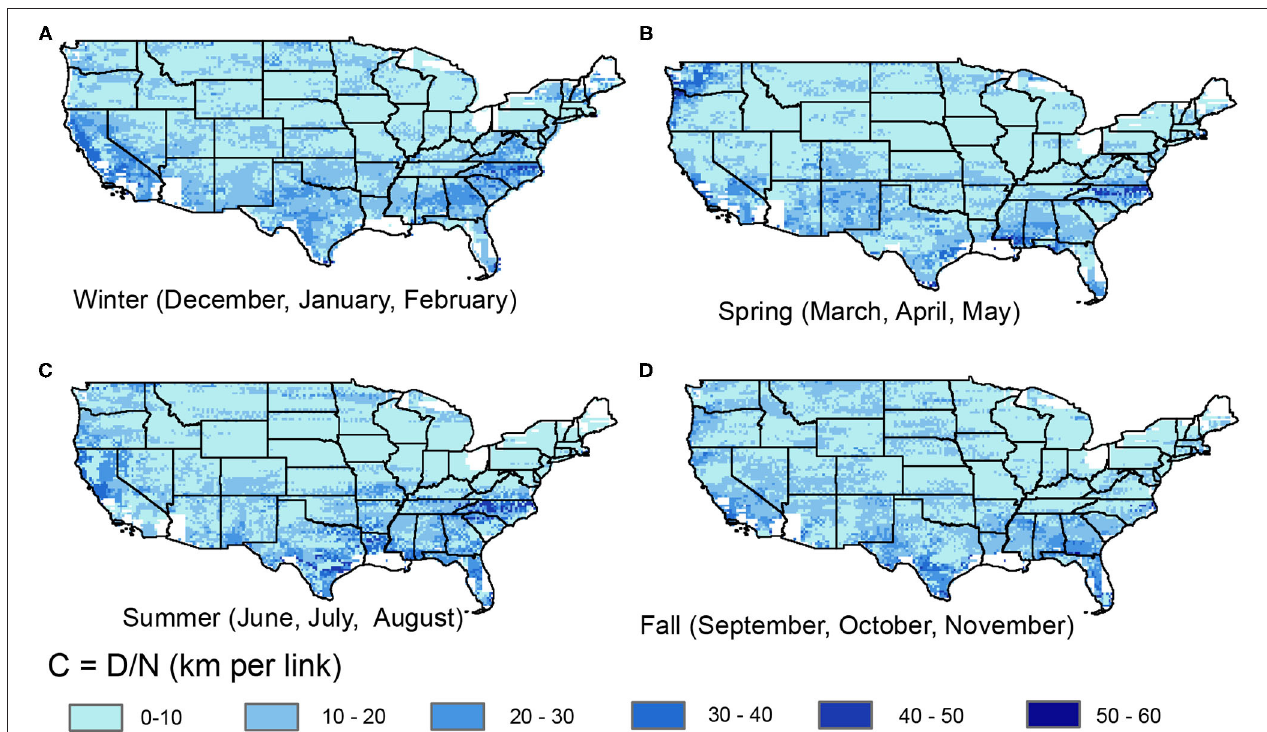
, km per link ) for precipitation chains for (A) winter, (B) spring, (C) summer, and (D) FIGURE 7 | Curvature ( C = D N